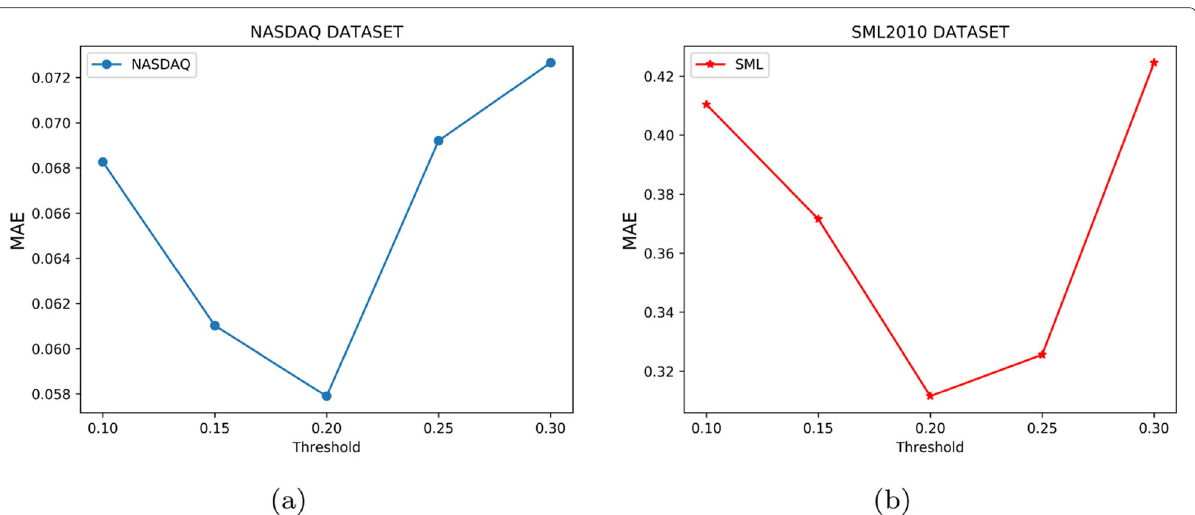
while, the performance of the VAECGAN model is no worse than the TCN model and DSTPRNN model in short-term perdition. The predicted value of the VAEC- GAN model is closer to the real value than the other model at the corner. Therefore, it can be proved that the performance of the VAECGAN model in prediction is better.